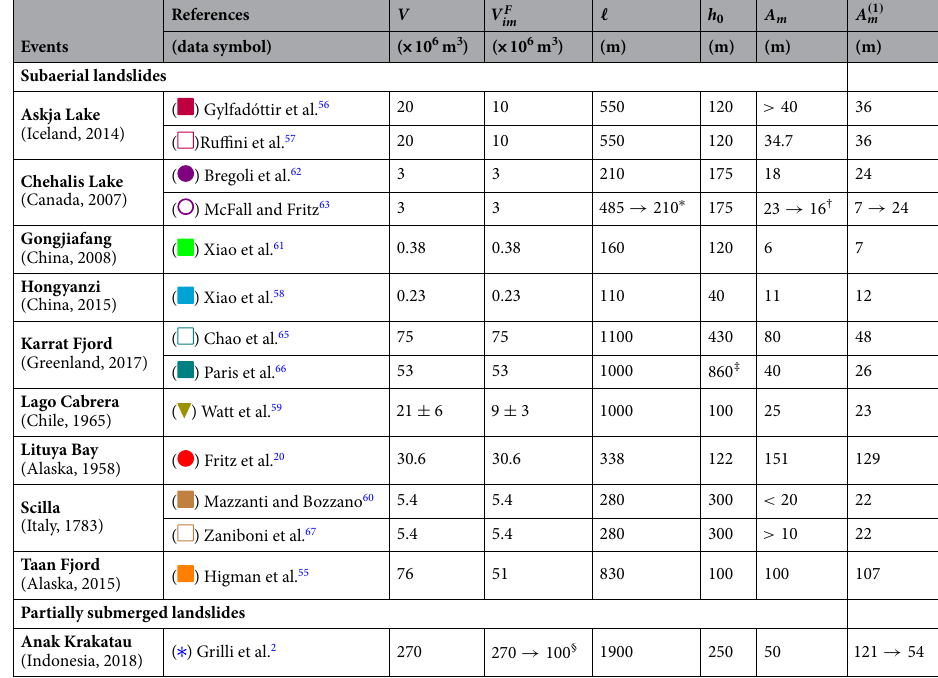
Table 1. Summary of field data extracted from the literature for 9 subaerial landslides and the recent partially submerged collapse of the Anak Krakatau volcano (2018) that have generated a tsunami wave. For each event and reference paper are indicated the mobilized volume of the landslide V , volume of the final immersed F h A m of the wave deposit V 0 , and estimated maximal amplitude im , typical lateral extent ℓ , typical water depth ( 1 ) generated near-shore. The last column corresponds to the maximal amplitude A m calculated with the scaling law (1). Data symbols correspond either to ( ) observations in the field, ( , ) experiments at reduced scale, (